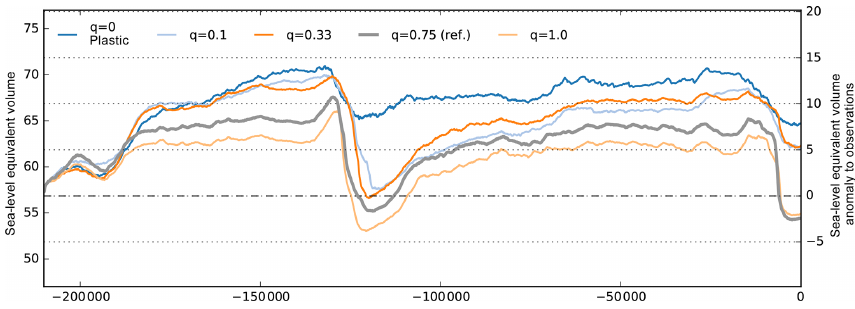
Figure 13. Antarctic ice volume history over the last two glacial cycles for different values of the basal sliding exponent q . Between plastic (blue) and linear sliding (light orange), the ice volume above flotation can vary by 6mSLE on average and by up to 12mSLE in interglacial periods. Generally, smaller values of q lead to slower ice flow and hence to larger ice